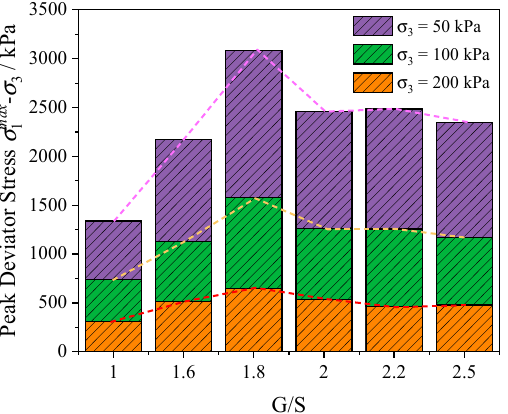
Figure 8. Histograms showing the values of peak deviator stress at failure obtained at different G/S levels from laboratory monotonic triaxial compression tests.